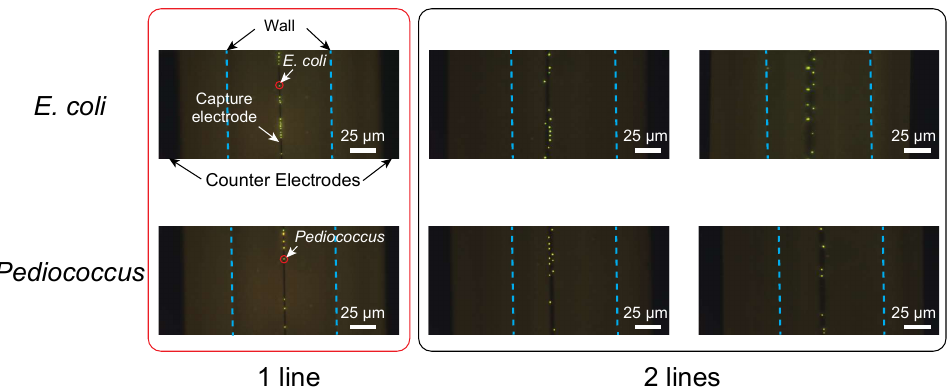
Figure 8. Electrode width dependence of the captured bacteria: Both E. coli at a flow rate of 590 μm/s and P. pentosaceus at a flow rate of 590 μm/s are similarly arranged in one row when the electrode was about 1 μm or less in width and are arranged in two rows at both edges of the electrode when the electrode was thick (3 μm to 5 μm).